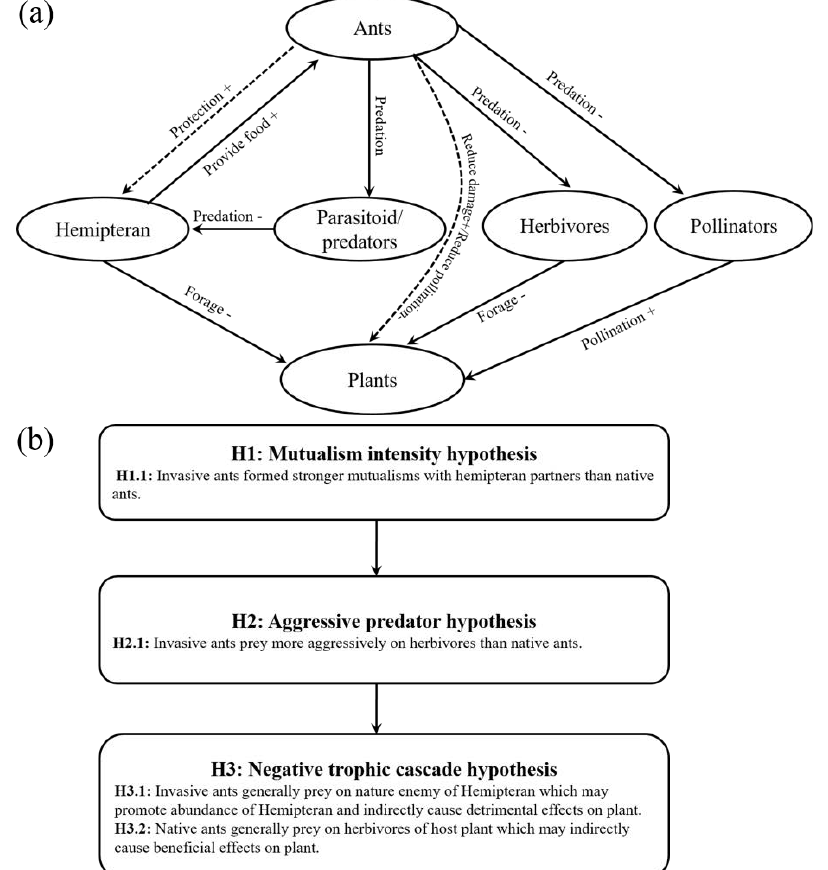
Figure 1. ( a ) Ants protect Hemiptera from preying/parasitic predators (e.g., ladybird, lacewing flies, spiders) or parasitic wasps, and hemipterans provide honeydew to ants as food hydrocarbon source. Ant predation or harassment on herbivores will have cascading effects on plant fitness. ( b ) Proposed hypotheses on cascading effects of both native and invasive ants on the local arthropod community and plant